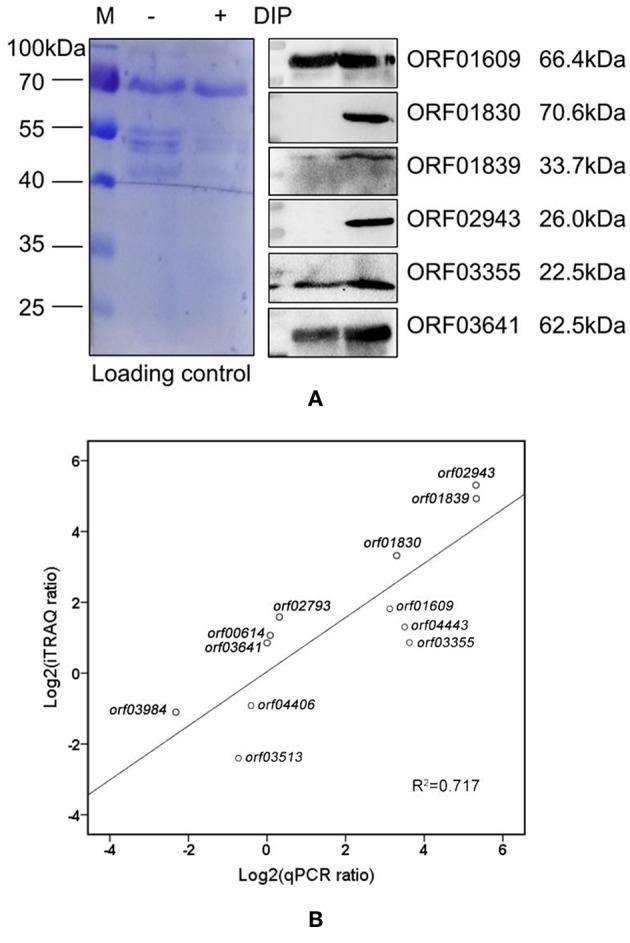
Correlations between selected genes and proteins. (A) Western blot of differentially expressed extracellular proteins in A. hydrophila LP-2 with and without DIP treatment. Coomassie R-350 stained on PVDF membrane was used as the loading control. (B) The correlation between mRNA expression and proteomics in nine upregulated genes (orf00614, orf01609, orf01830, orf01839, orf02793, orf02943, orf03355, orf03641, and orf04443), and three downregulated genes (orf03513, orf03984, and orf04406).